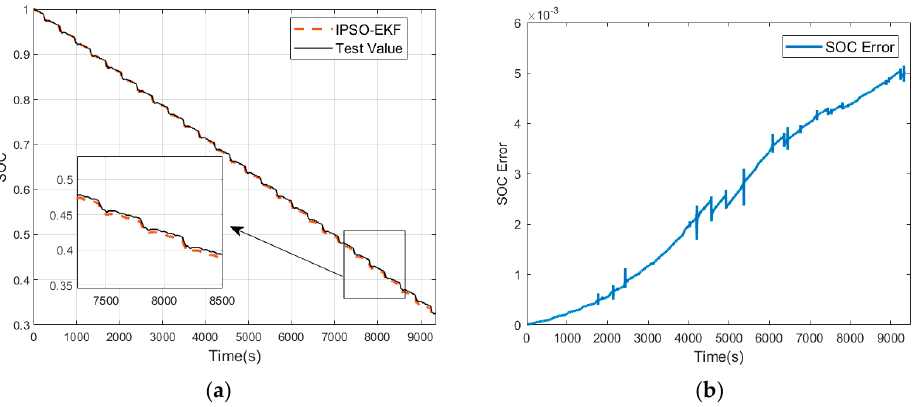
Figure 5. SOC estimation result: ( a ) SOC change curve and ( b ) absolute error of SOC estimation.